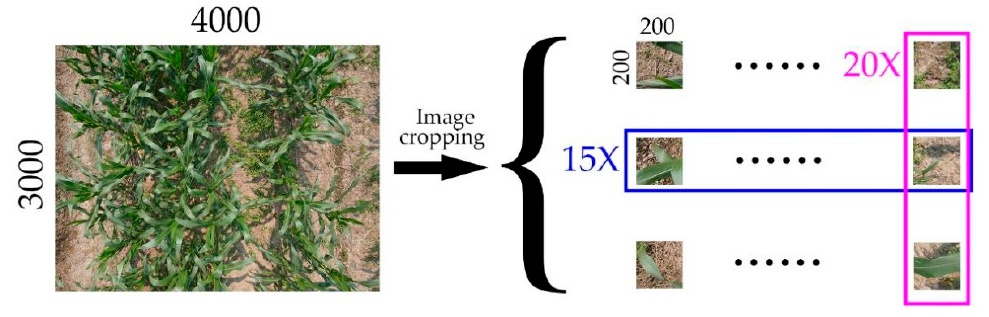
Figure 3. An image cropped from 1 × 3000 × 4000 to 300 × 200 × 200.